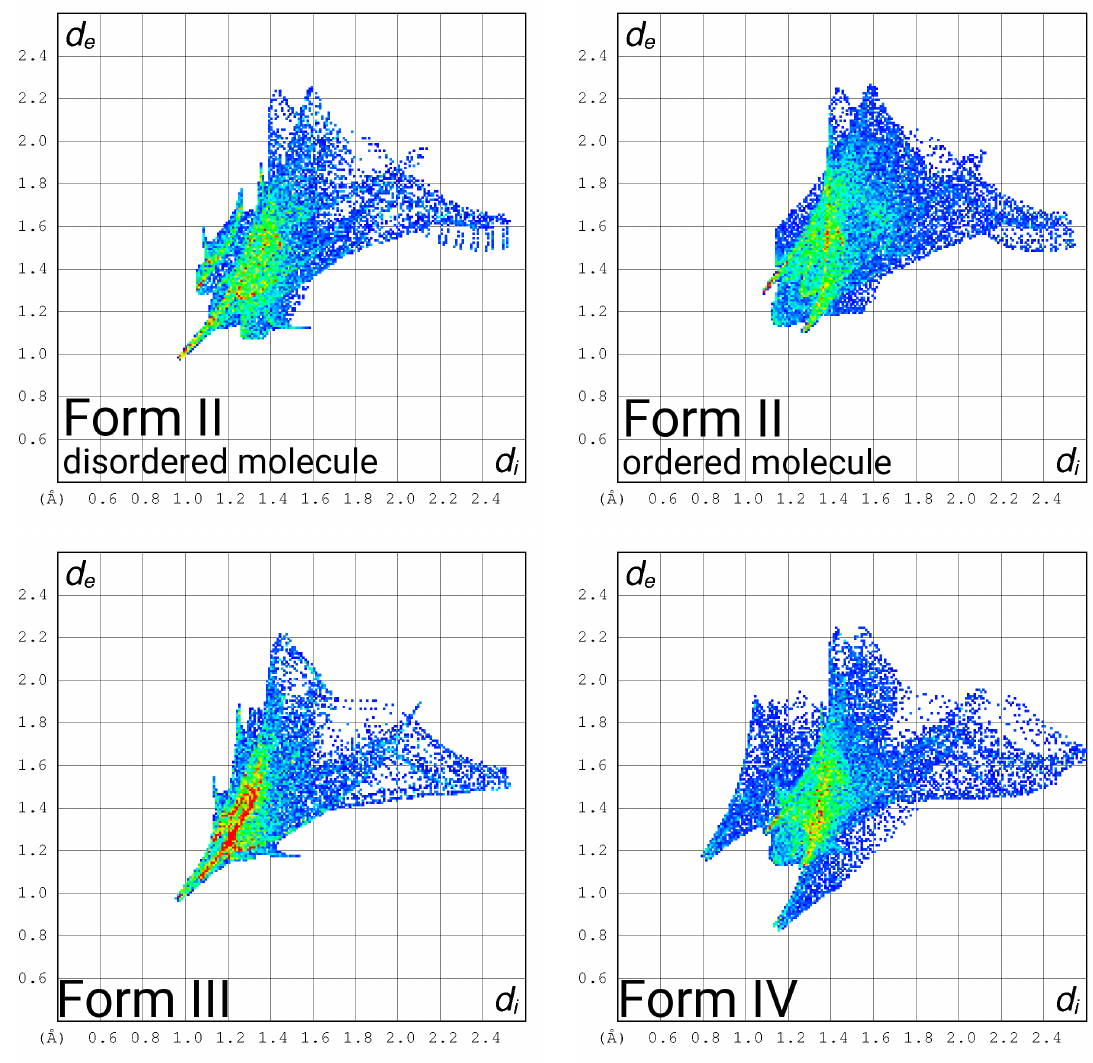
Figure 2. Fingerprint plots calculated from the Hirshfeld surfaces for Forms I (top, with the molecule in a special position on the right), II (middle, with the disordered molecule on the left), III and IV of sodium acetate as generated with CrystalExplorer 17